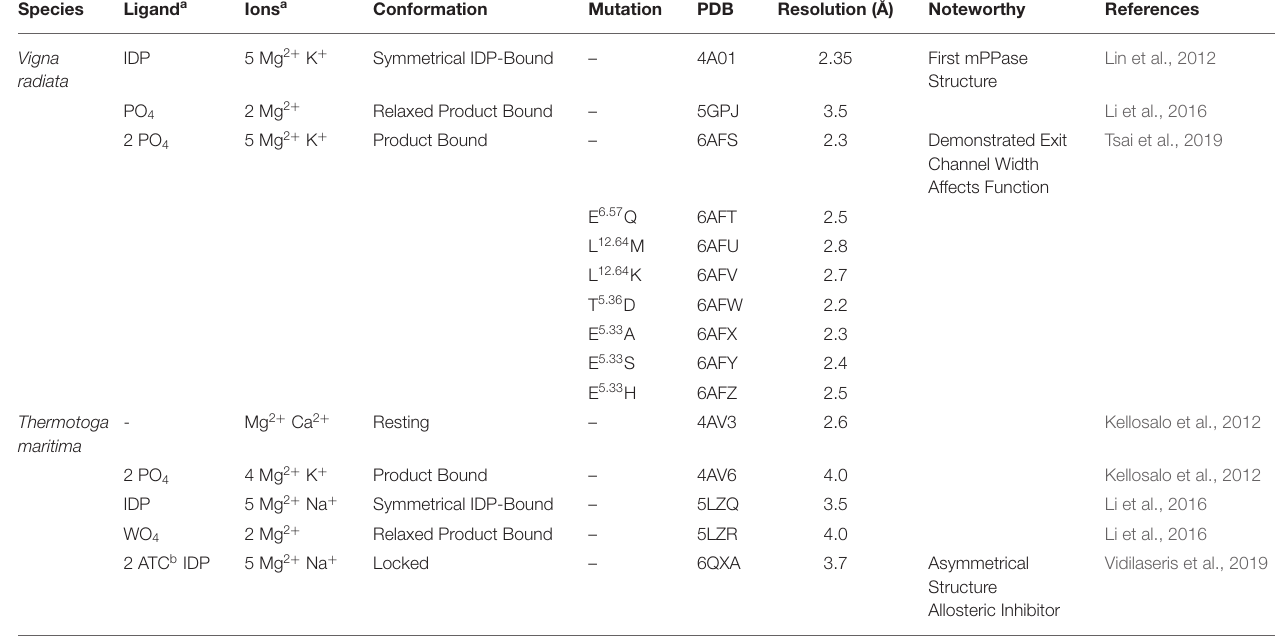
TABLE 2 | Published mPPase